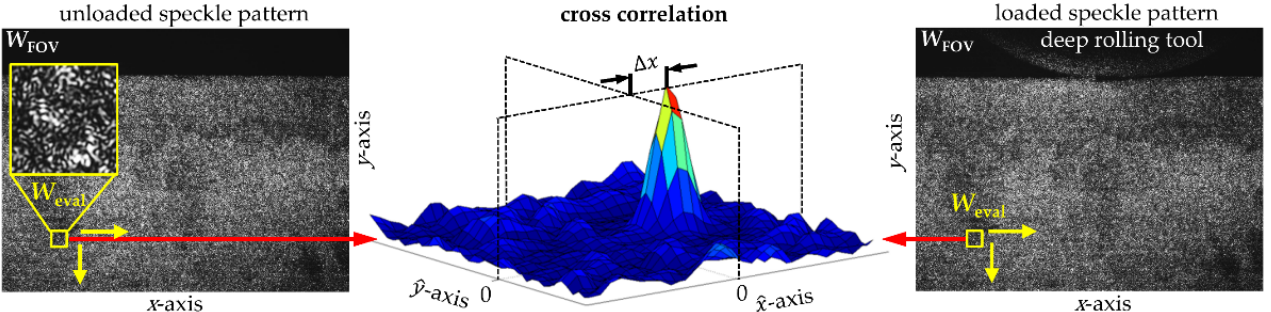
Figure 1. Evaluation principle of speckle photography for the measurement of the two-dimensional in-plane deformation.